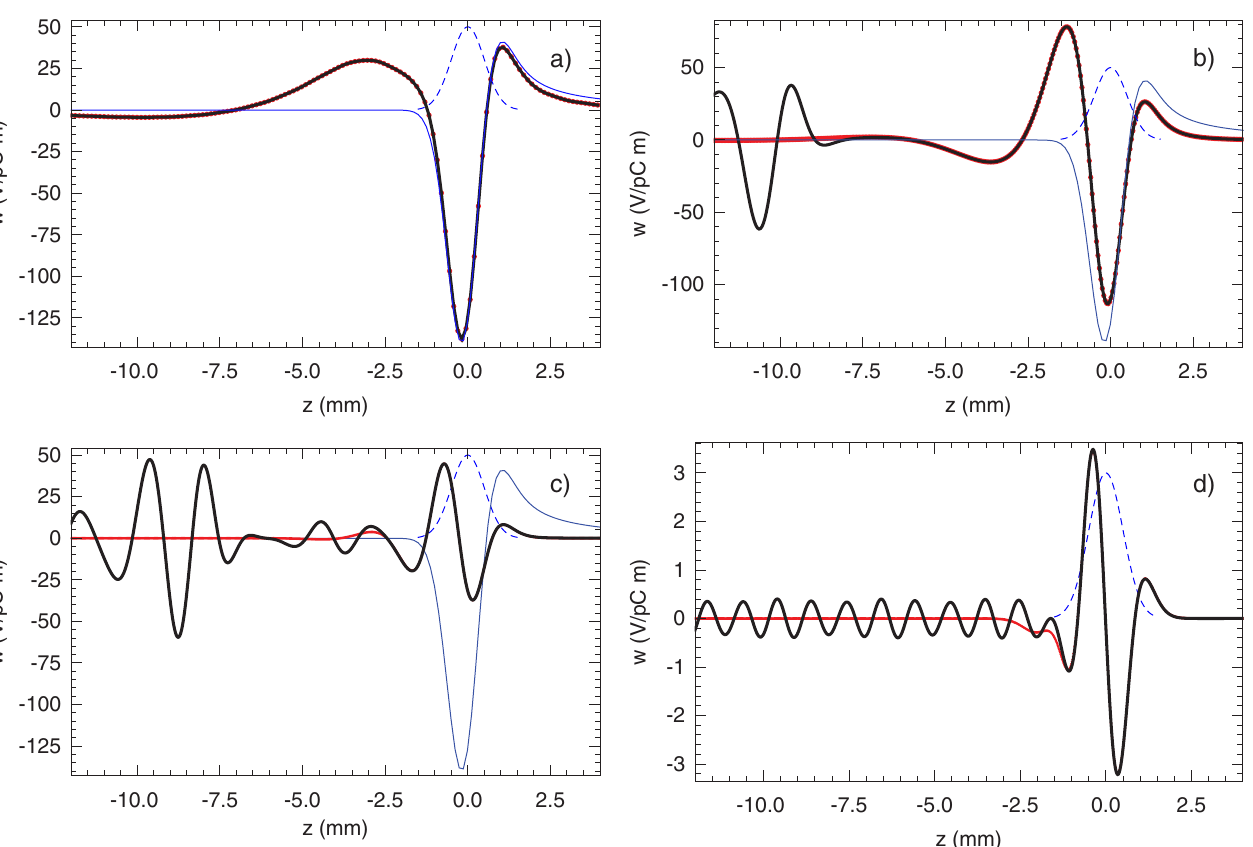
FIG. 3. (Color) Steady state wakefields in the toroid for the aspect ratio A ¼ 3 and various values of b : (a) b ¼ 4 cm , (b) b ¼ 2 cm , (c) b ¼ 1 cm , and (d) b ¼ 0 : 5 cm